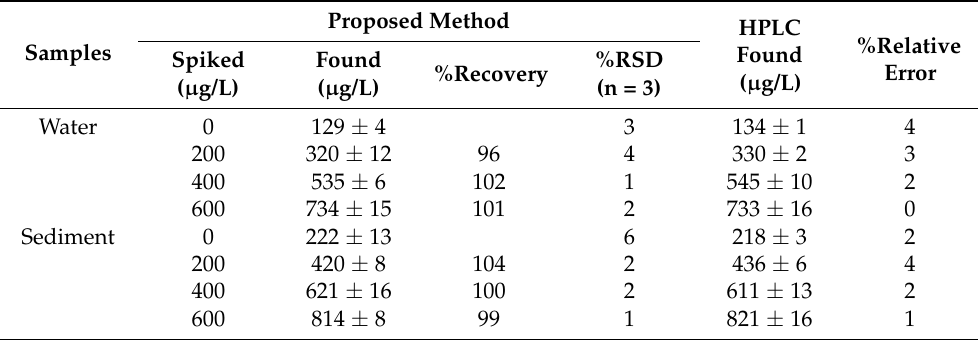
Table 3. A comparison between the proposed and traditional methods for MT in water and sedi- ment